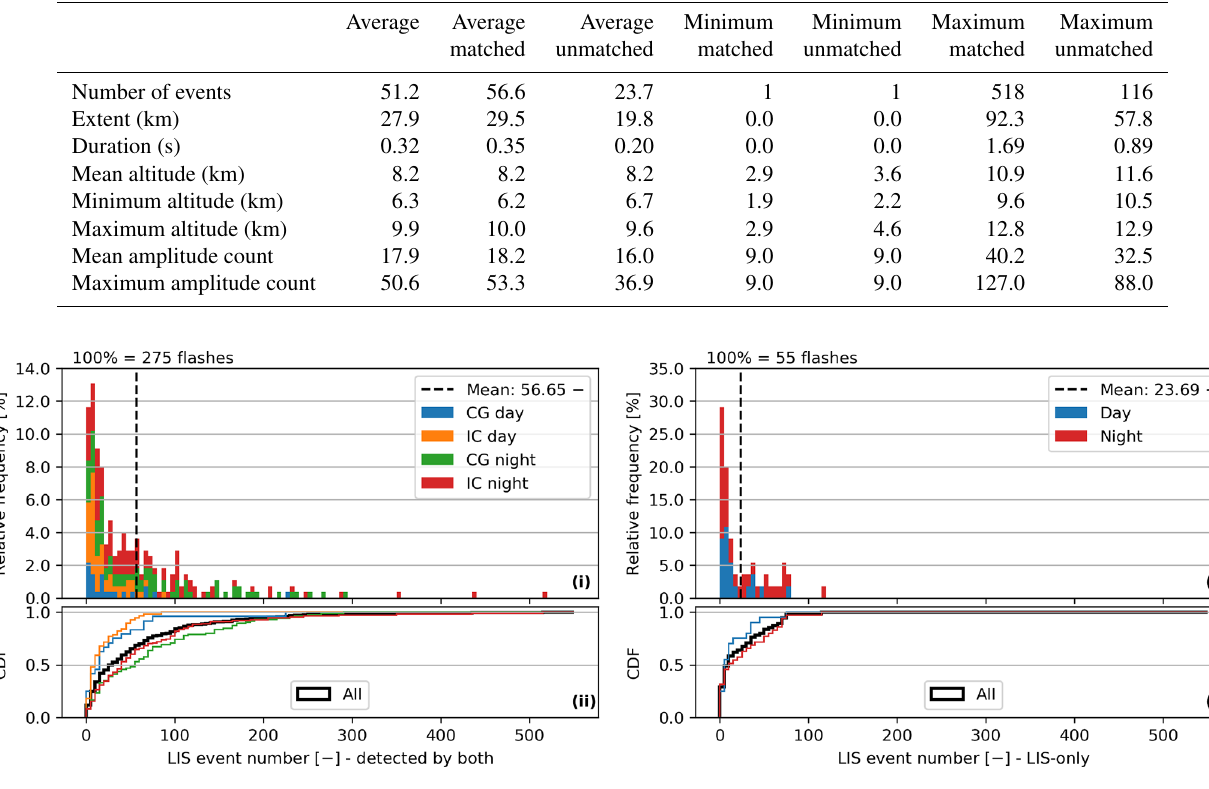
Table 2. Overall average and the average, minimum and maximum values of ISS-LIS flash characteristics for matched and unmatched flashes. The minimum (maximum) altitude represents the 10th (90th) percentile of concurrent SAETTA sources. Amplitude count is recorded per event.